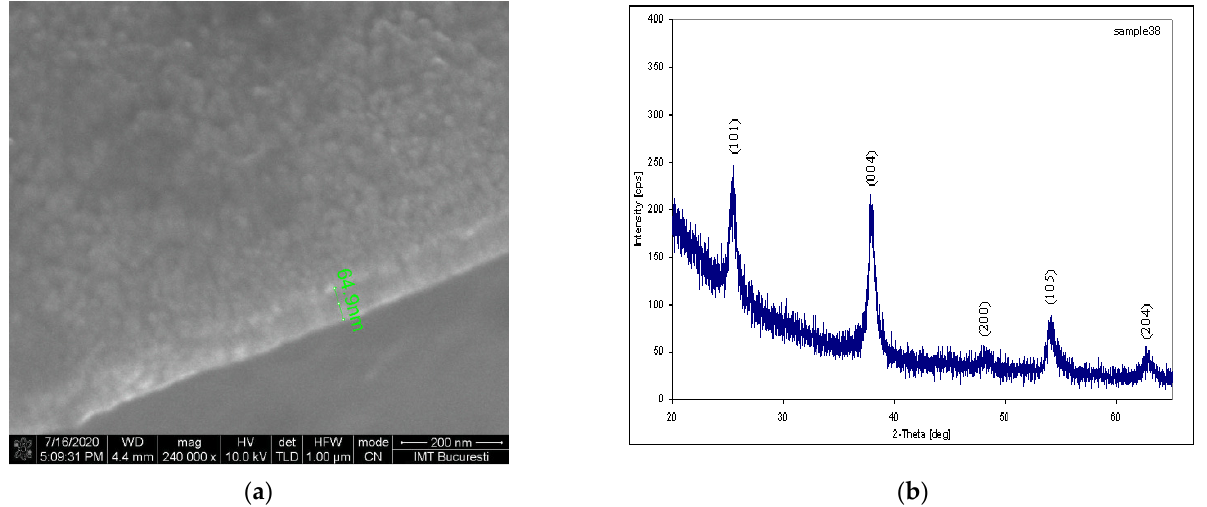
Figure 7. ( a ) SEM image for a TiO 2 film converted to a nanostructured film at 450 °C in an N 2 environment located over the FET gate. ( b ) XR spectrum for the same TiO 2 film.